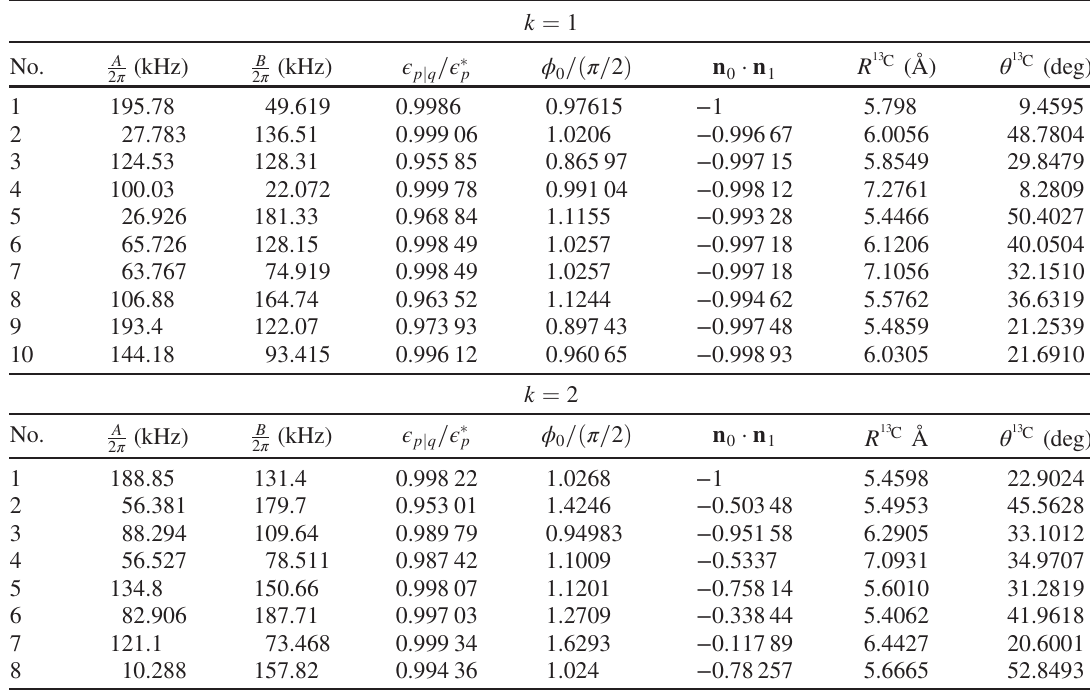
TABLE II. Parameters for the k ¼ 1 CPMG resonances in Figs. 6(a) and 6(b) and the k ¼ 2 CPMG in Figs. 6(c) and